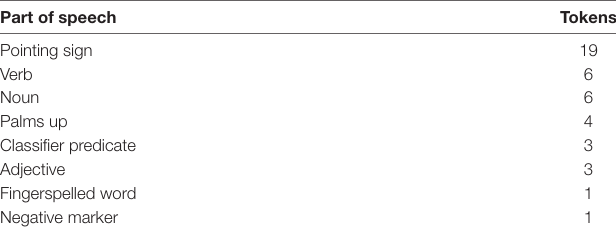
TABLE 1.2 | Target signs of